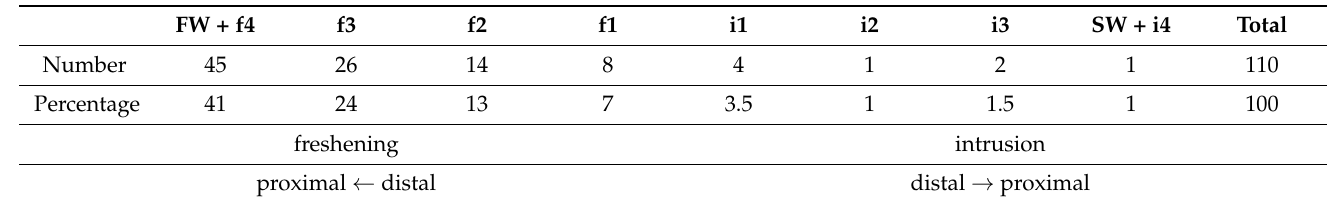
Figure 7. ( a ) HFE diagram and ( b ) distribution of sub-stages of water samples in the Luy river catch- ment, the red balls are the samples in the intrusion zone and the blue balls are in the freshening zone. Table 2. Distribution of sub-stages in freshening and intrusion phases for 110 water samples collected in the rain season 2020.